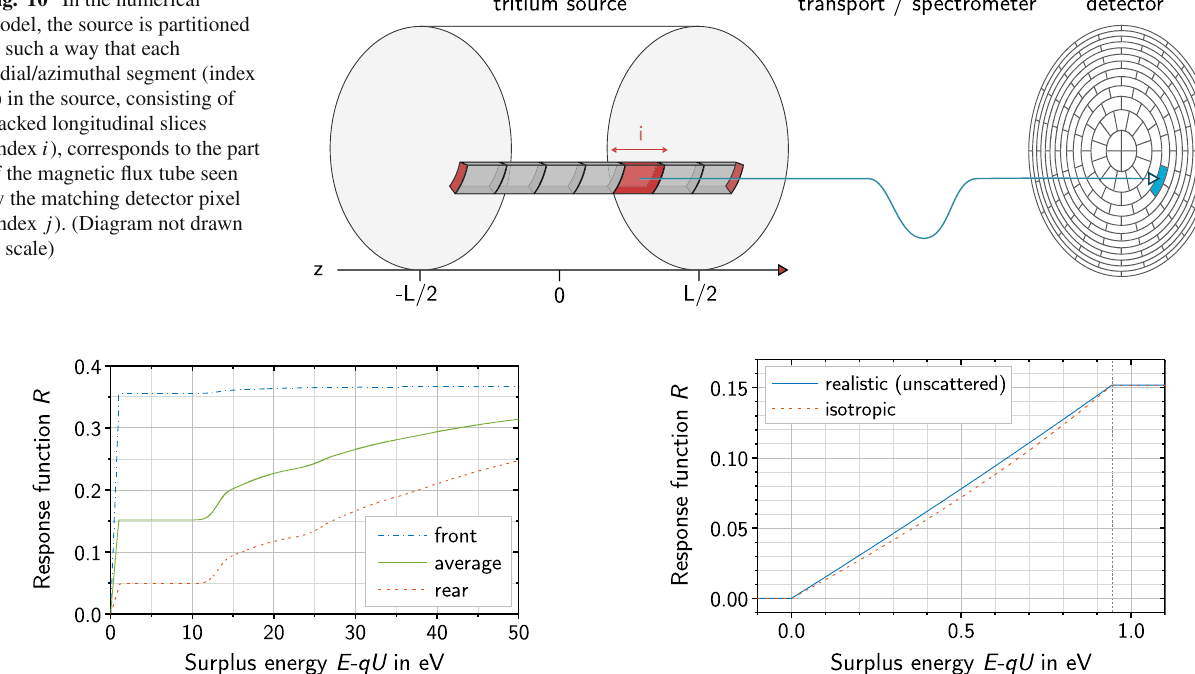
Fig. 12 The transmission edge of the response function. The dashed curve is calculated with an isotropic angular distribution, and the solid curve with a realistic angular distribution for unscattered